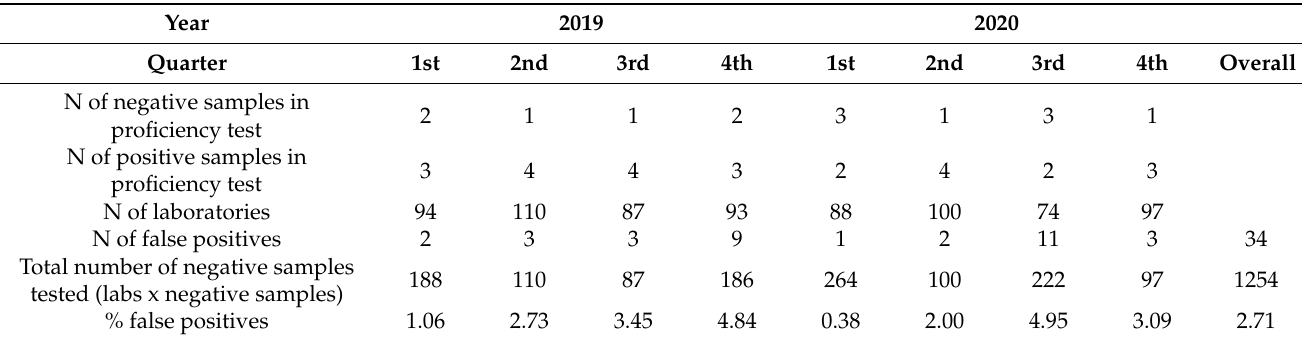
Table 3. Number (N) of Salmonella proficiency test results of laboratories from several countries in the period 2019–2020. (source: VETQAS, proficiency testing for veterinary laboratories; Animal and Plant Health Agency, UK.).